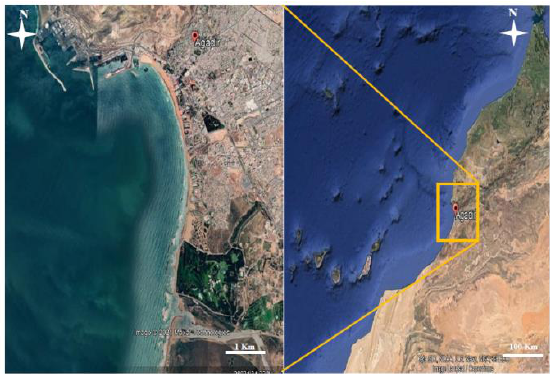
Figure1 . Agadir Bay's Geographic location